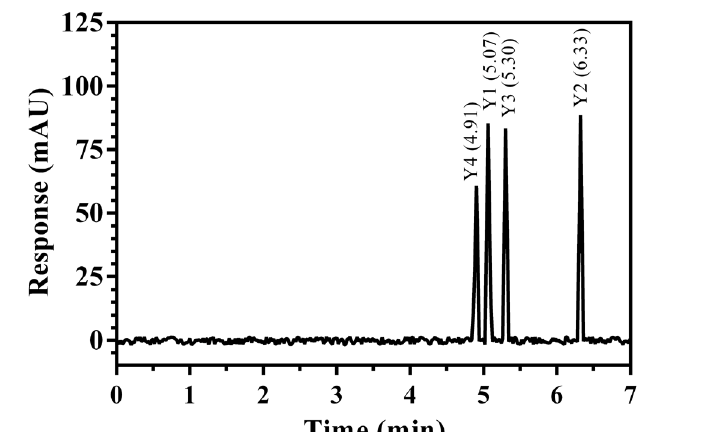
FIGURE 1 - Representative electropherogram of PGZ (Y1), Keto-P (Y2), OH-P (Y3), and RSG (Y4). RSG is the internal standard (IS). The optimized electrophoretic conditions were: uncoated fused silica capillary, 47.5 cm (40 cm effective length) × 50 m id.; hydrodynamic injection (50 mBar, 15 s), running buffer of 50 mmol/L phosphate buffer solution (pH 2.5); UV detection at 190 nm; capillary temperature of 35ºC and applied voltage of 30